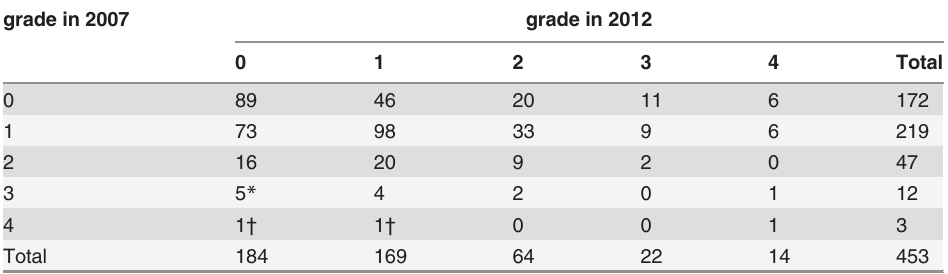
Table 2. Diabetic retinopathy grades of the worse eye of 453 participants in the baseline survey in 2007 and the final survey in